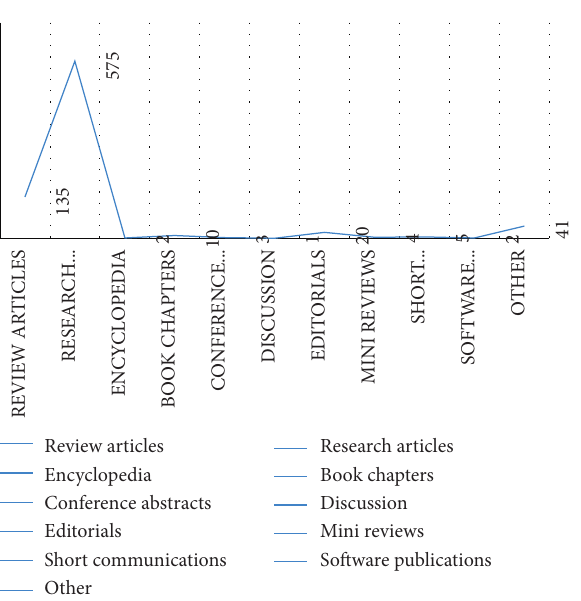
Figure 9: Article type and papers.